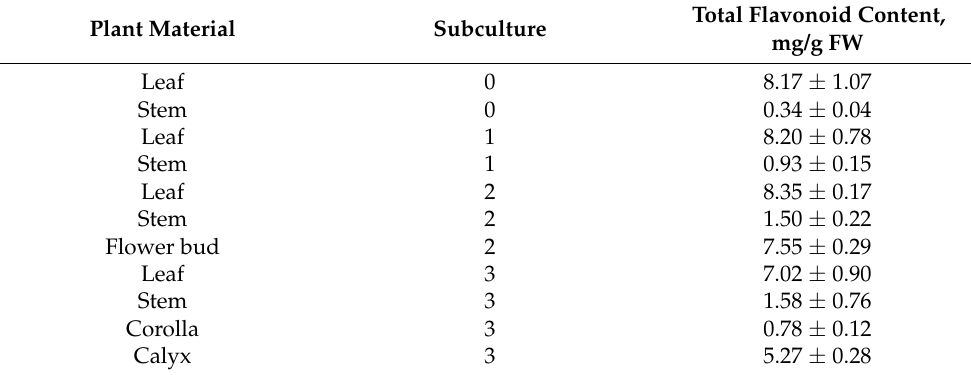
Table 1. Total flavonoid content in various parts of S. hortensis aseptic plants. Plant Material